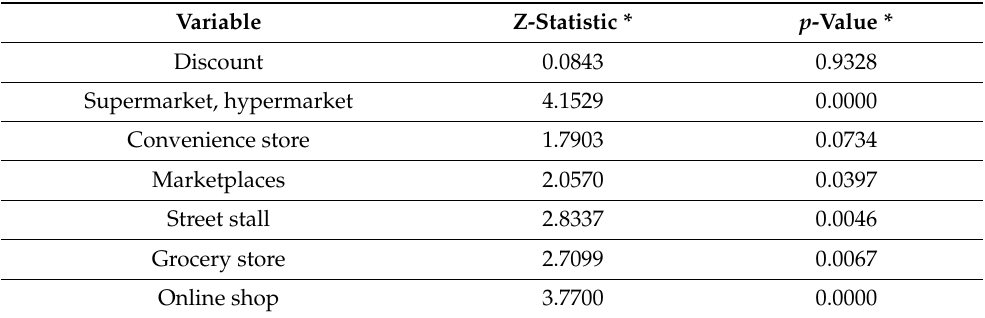
Table 4. Variations in the frequency of buying fruits and fruit preserves from selected sources for innovators and non-innovators.